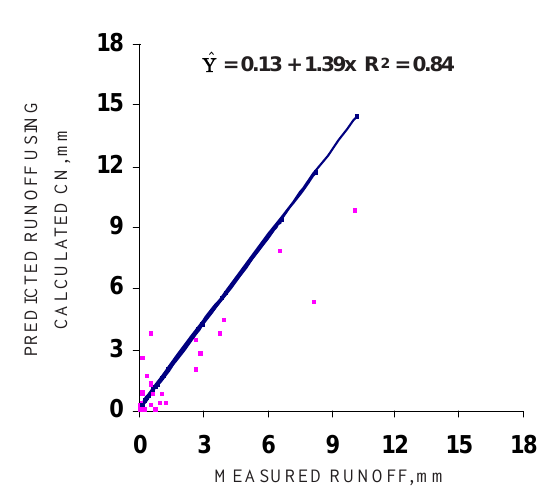
Table 3. Summary of multiple regression analysis (using Statistics Analysis System –